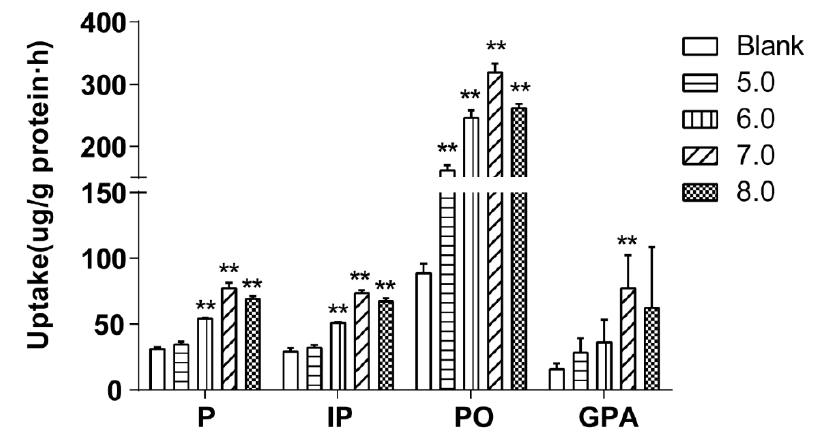
Figure 6. The cellular uptake of the 4 component compounds at different pH values. Significance: vs. blank medium: ** p < 0.01.